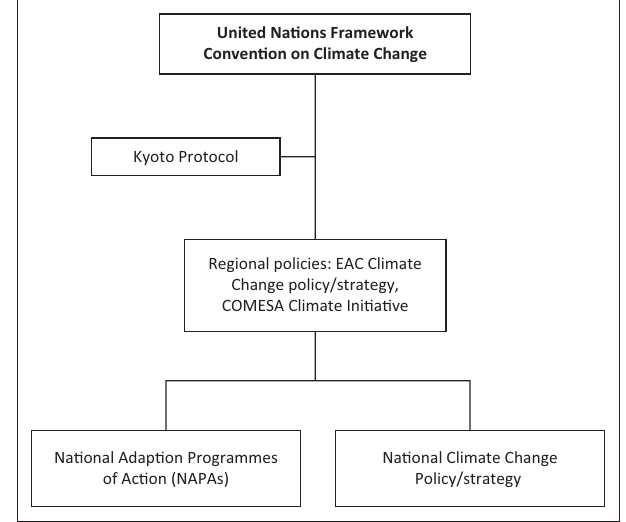
FIGURE 2: Framework for incorporation of wildlife management issues in climate change policy.